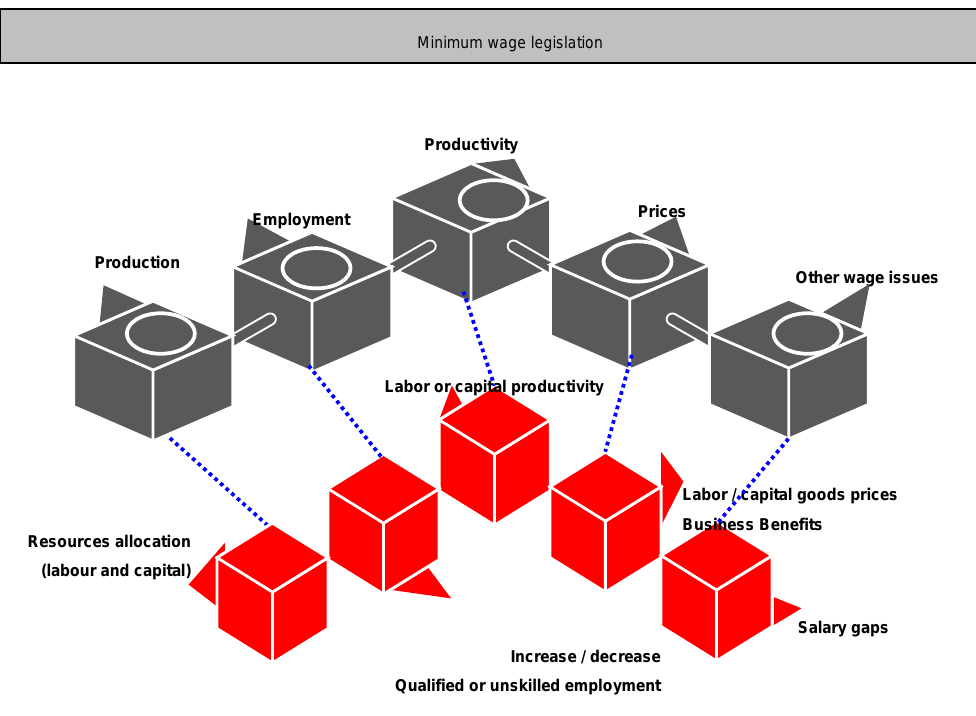
Figure 1: Hypothesis on the economic-labor incidence of minimum wages